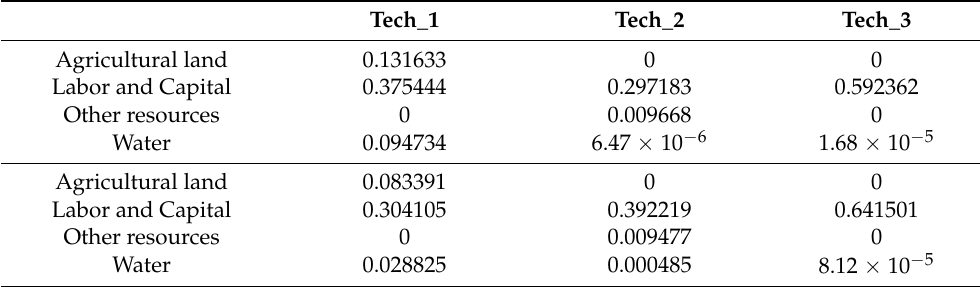
Table 2. F matrix of the water split of former Factor 2 into a new Factor 2 and Factor